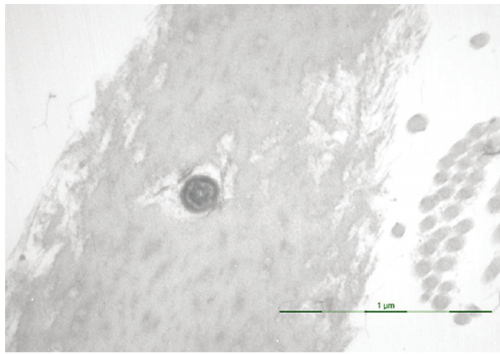
Figure 2: Calcified microcyst in an elastic fiber.